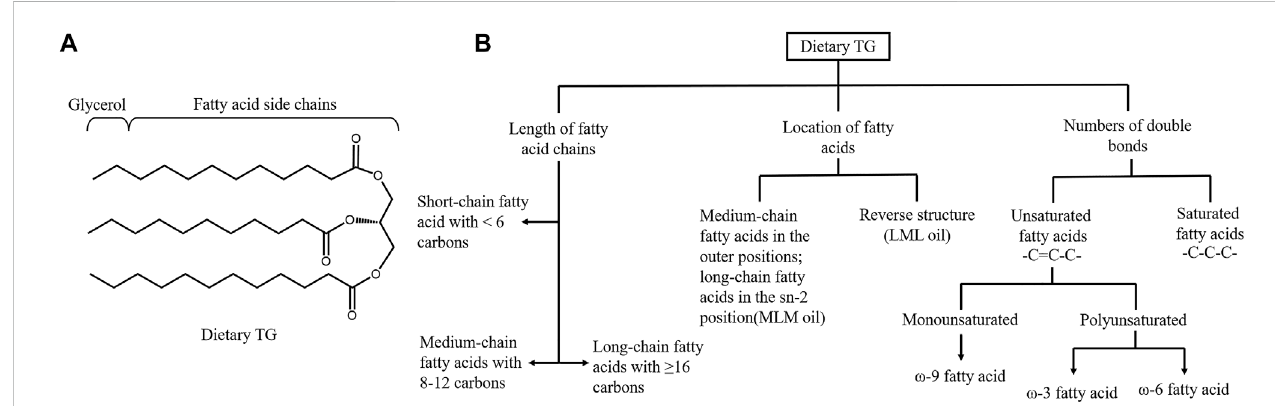
FIGURE 2 Structure and classi fi cation of dietary triglyceride. (A) Structure of triglyceride (TG). Pancreatic lipase hydrolyzes the sn-1 and sn-3 positions of TGs to generate sn-2 MGs and freefatty acids. (B) Dietary triglyceride can beclassi fi edbased on thelength of fatty acid (FA) chains, thelocation of different length of FAsinTGandthenumbersofdoublebondsinthehydrocarbonchains.Basingonthenumbersofcarbons,FAscanbesubcategorizedintoshort,mediumand long-chainFAs.ThreeFAsintheTGcontributetothedifferentstructuredoil,includingmedium-chainFAintheouterpositionsoftheTGandlong-chain FA in the sn-2 position and the reverse structure. Unsaturated FAs contains double bonds while saturated FAs only have single bonds. Unsaturated FAs are further categorized in to monounsaturated FAs and polyunsaturated according to the number of the double